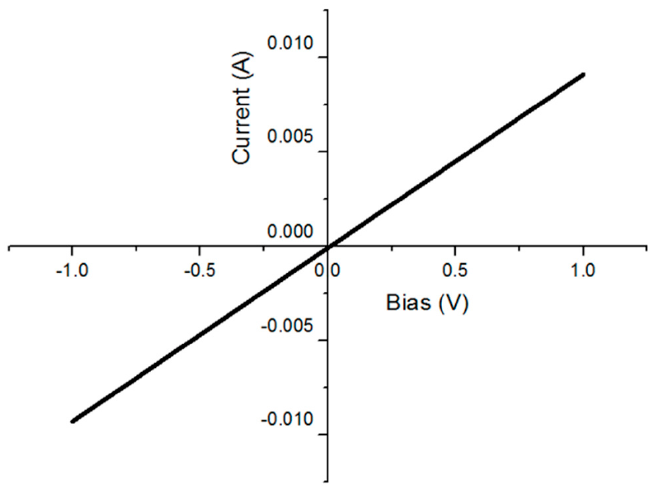
Figure 5. Current-voltage characteristics of the FeS 2 /PIS thin film.